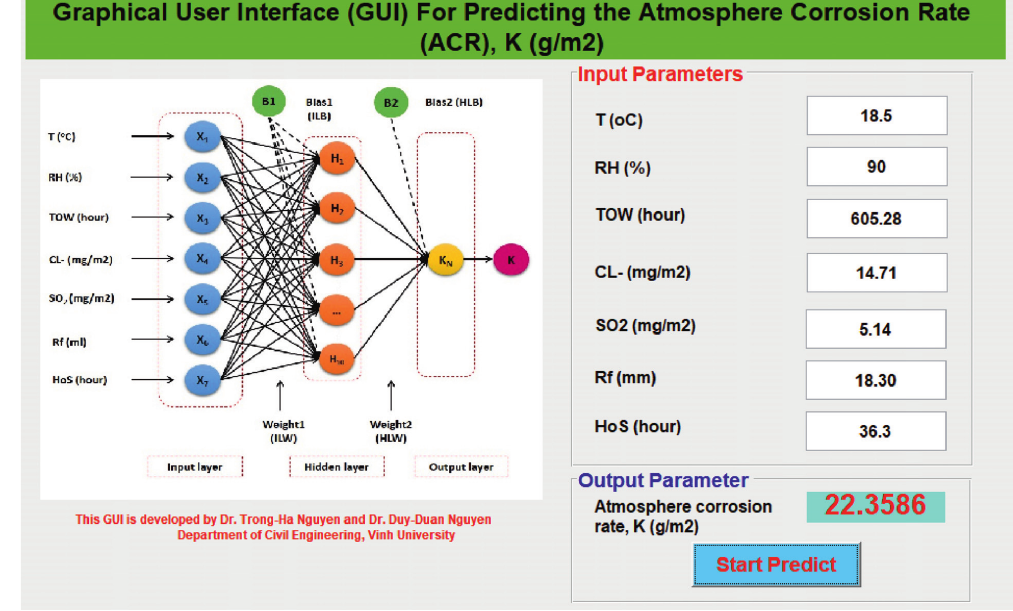
Figure 21: Practical GUI tool for predicting K . Table 7: Coefficients for formulation of the atmospheric corrosion